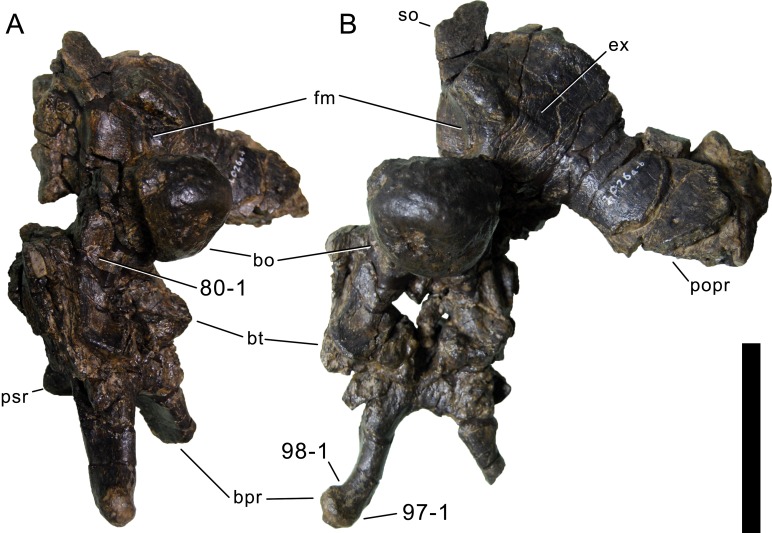
Braincase of Losillasaurus giganteus MCNV Lo-26 in posterolateral (A) and posterior (B) view.Note the lateral basioccipital depression between the foramen magnum and the basal tubera (A; C80-1); the laterally curving distal ends of the basipterygoid processes (B; C97-1), as well as their distinct transverse expansion (B; 98-1). Abb.: bo, basioccipital; bpr, basipterygoid process; bt, basal tuber; ex, exoccipital; fm, foramen magnum; popr, paroccipital process; psr, parasphenoid rostrum; so, supraoccipital. Scale bar = 10 cm.